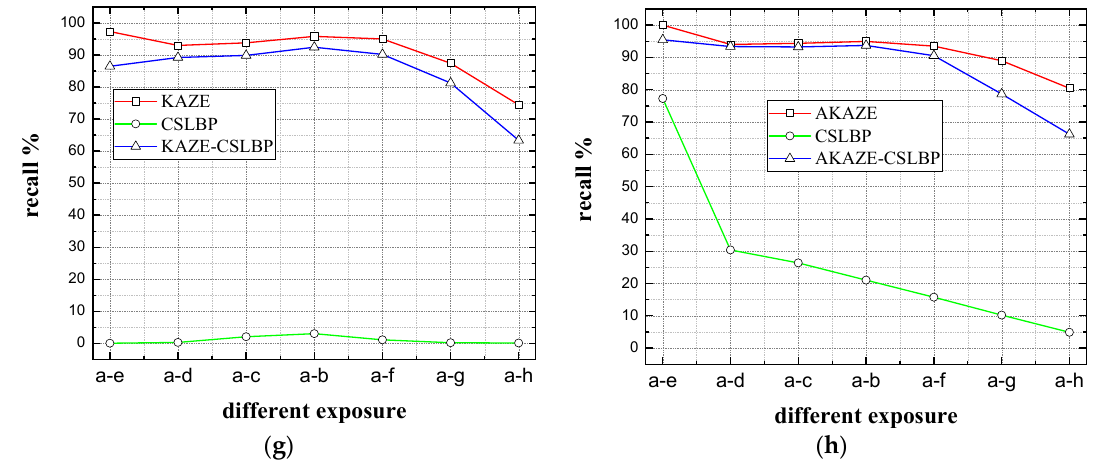
Figure 17. Matching results of the recall of Ubc sequence for the eight original, the CSLBP, and the combined descriptors. The X label represents the matched images of Ubc sequence, and the Y label denotes the recall for each descriptor. ( a ) SIFT features; ( b ) SURF features; ( c ) DAISY features; ( d ) BRISK features; ( e ) ORB features; ( f ) FREAK features; ( g ) KAZE features; ( h ) AKAZE features.